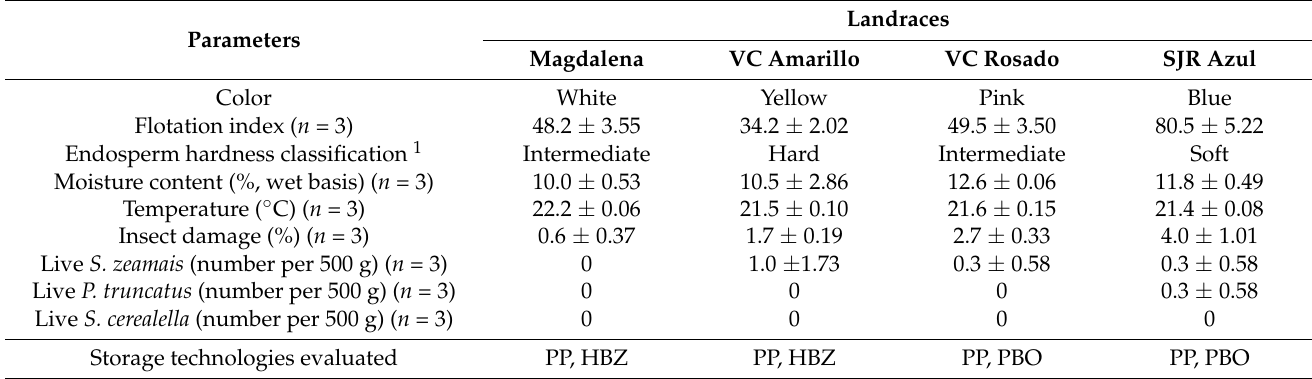
Table 1. Average ( ± standard deviation) damage parameters at the beginning of the experiment. Parameters